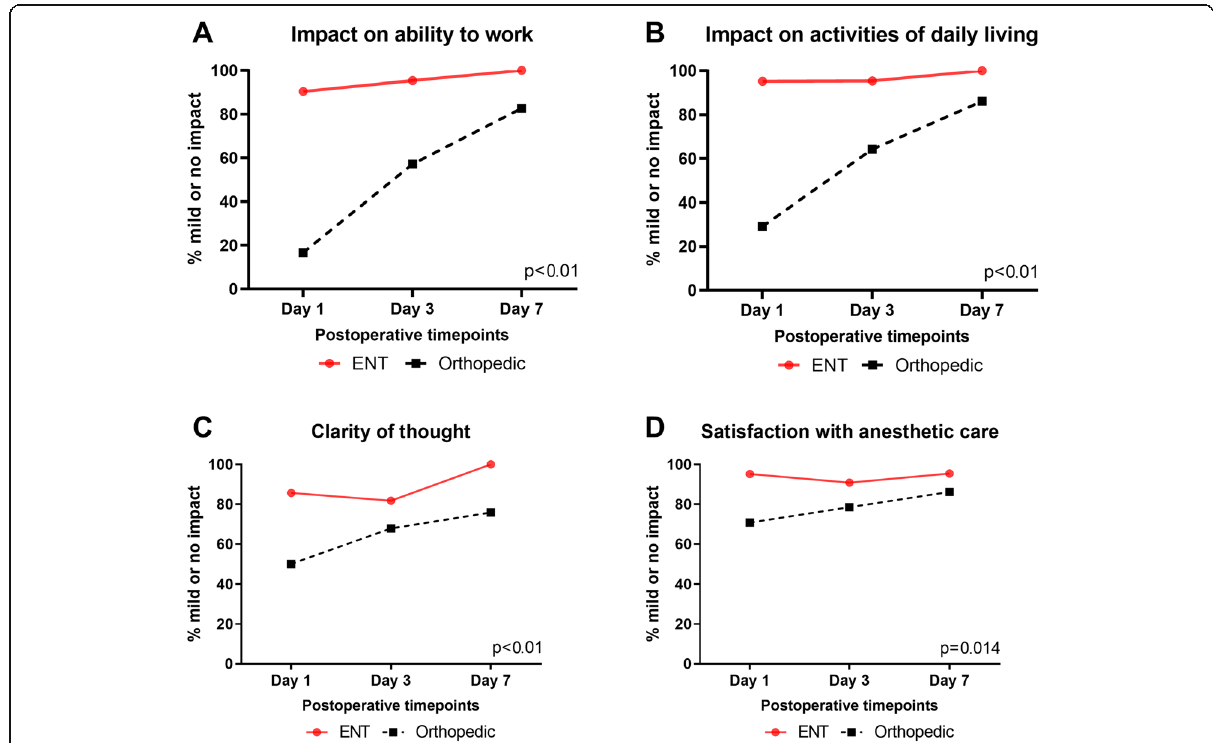
Fig. 3 Overall patient perspective. Patient perspectives of the procedure included the operations impact on their ability to work, effect on their activities of daily living, clarity of thought, and overall satisfaction with the anesthetic care. All p values for group differences over time are presented by the GLMM and represent time by treatment